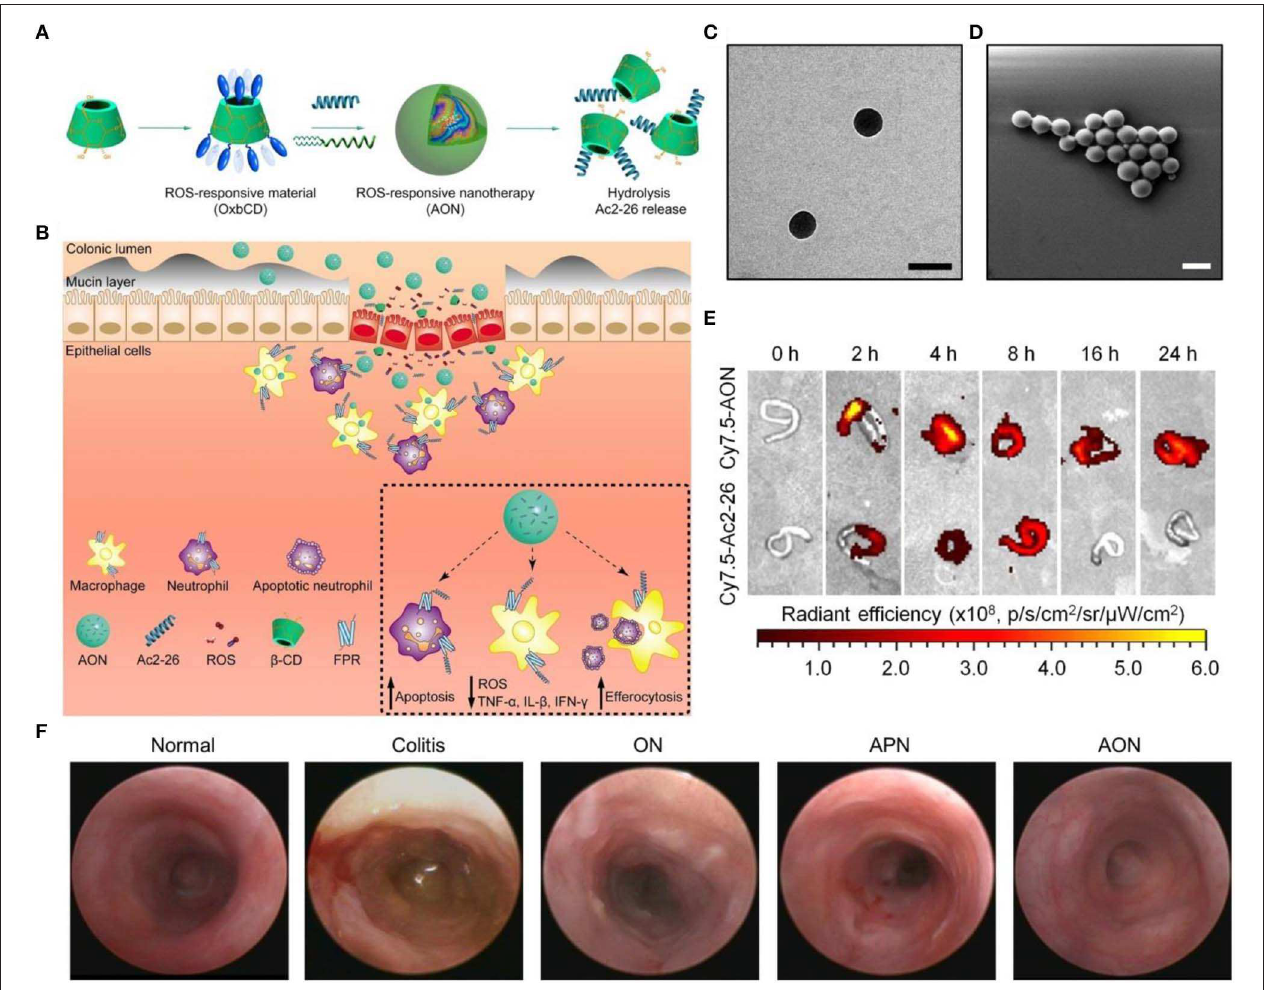
FIGURE 5 | A proresolving peptide nanotherapy for site-specific treatment of inflammatory bowel disease. (A,B) Schematic illustration of engineering of a ROS-responsive peptide nanotherapy (AON) (A) and targeted treatment of colitis (B) . (C,D) TEM (C) and SEM (D) images of AON. Scale bars, 200nm. (E) Selective accumulation of AON in the inflamed colons of mice with acute colitis. (F) Representative mini-endoscopic images of colons from colitic mice at day 7 after different treatments. ON, blank nanoparticles based on the ROS-responsive material of PBAP-conjugated β -CD (i.e., OxbCD); APN, Ac2-26-containing nanoparticles based on a non-responsive polymer PLGA. Reproduced with permission from Li C. et al.